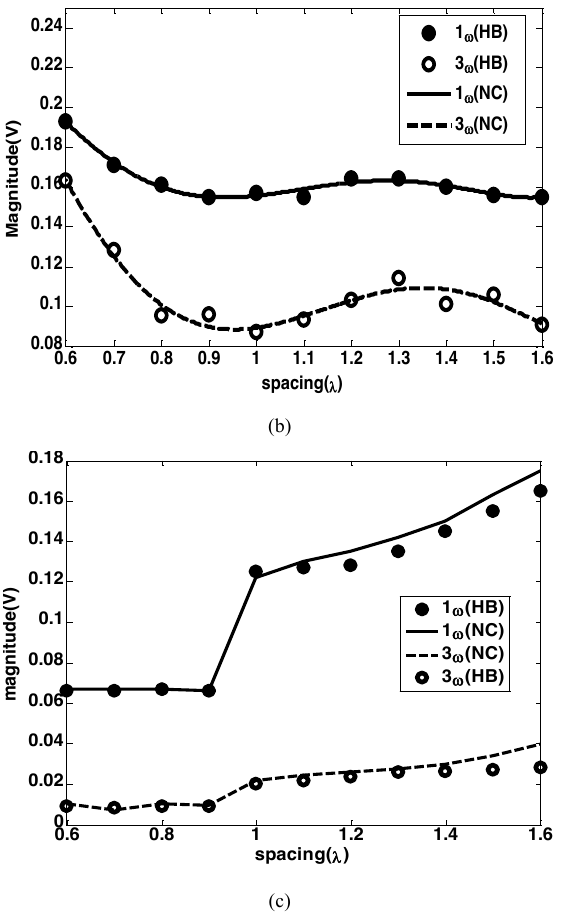
FIGURE 9. Magnitude of induced voltage across the Gun diode under single- tone excitation by NC and HB techniques in (a): parallel, (b): collinear, and (c): planar arrangements.